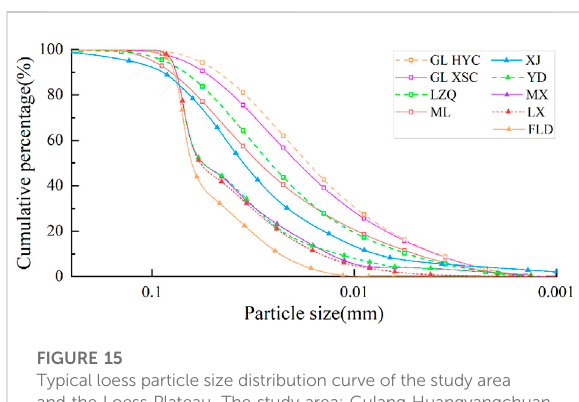
FIGURE 15 Typical loess particle size distribution curve of the study area and the Loess Plateau. The study area: Gulang Huangyangchuan (GL HYC), Gulang Xiashancun (GL XSC), Liangzhouqu (LZQ), Minle (ML);theLoessPlateau:Xiji(XJ),Yongdeng(YD),Minxian(MX), Linxia (LX), Fenglingdu